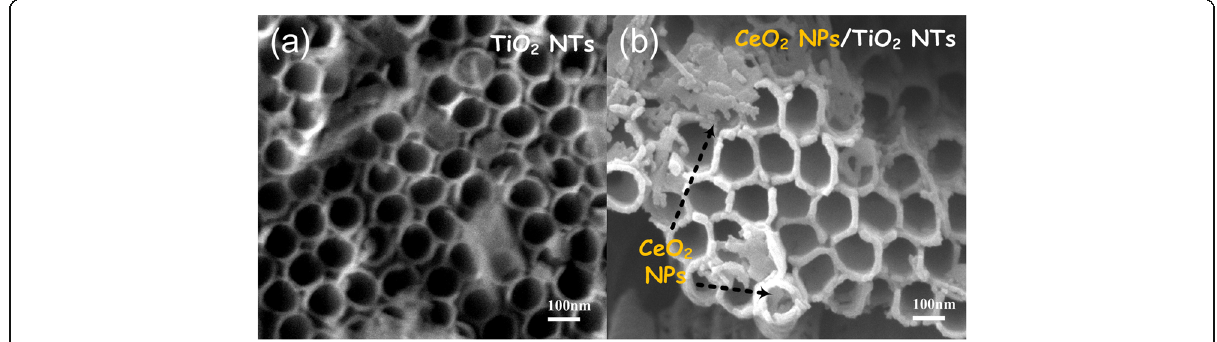
Fig. 4 Typical SEM images of a pure TiO 2 nanotube arrays without modification and b the CeO 2 /TiO 2 heterojunction, indicating the highly ordered structure with open tube mouth morphology, and after modification, CeO 2 was successfully loaded into the TiO 2 nanotube